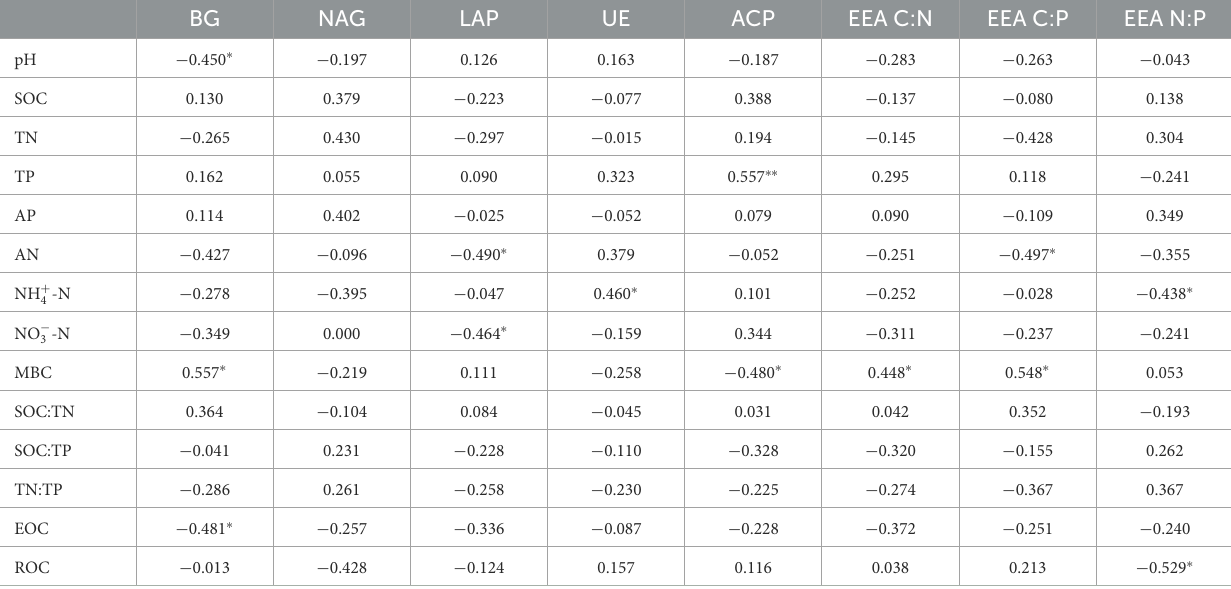
TABLE 3 Pearson correlation between soil enzymes, stoichiometric ratios, and soil physicochemical properties.